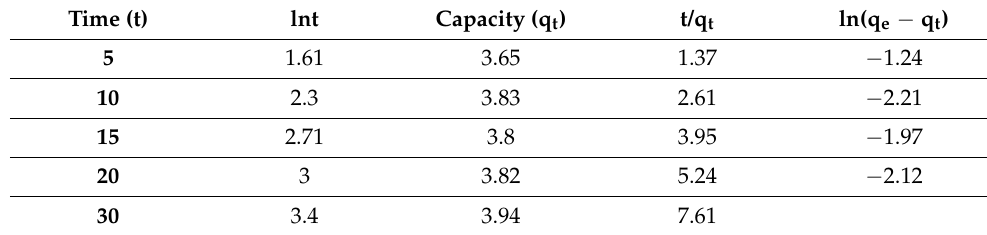
Table 6. The values used in the calculation of kinetic models’ parameters and constants. Time (t) lnt